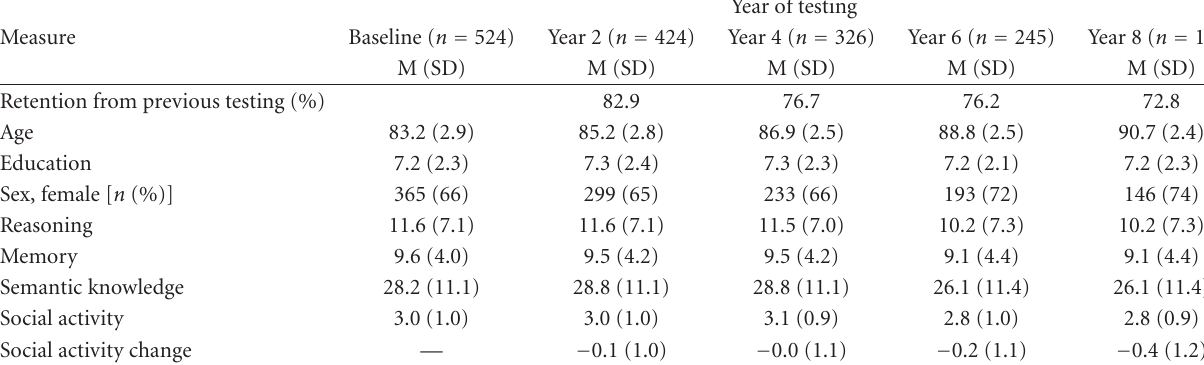
Table 1: OCTO-twin participant characteristics.